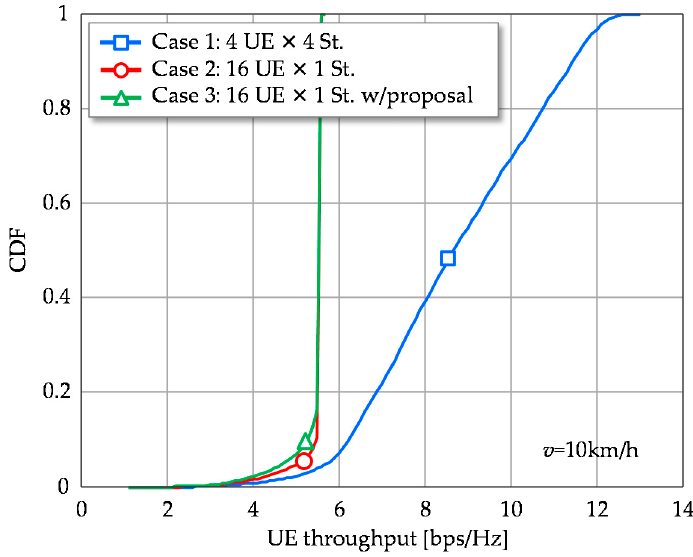
Figure 7. CDFs of UE throughput.